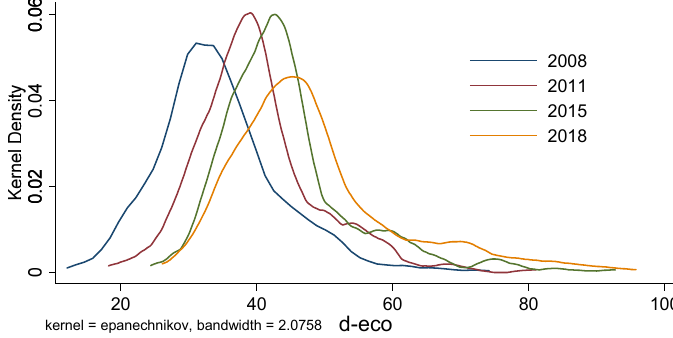
Figure 3. Temporal evolution of the digital economy.